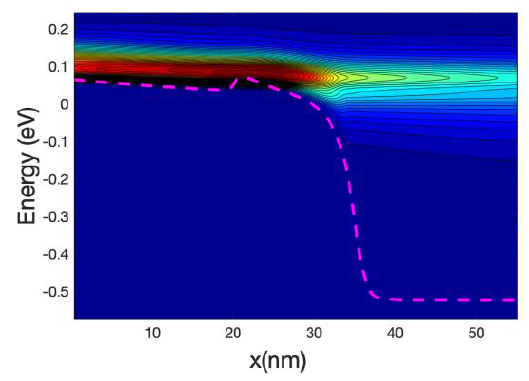
Figure 14. Energy resolved current spectra Vg = 0.7 V, hot electrons and selfheating.